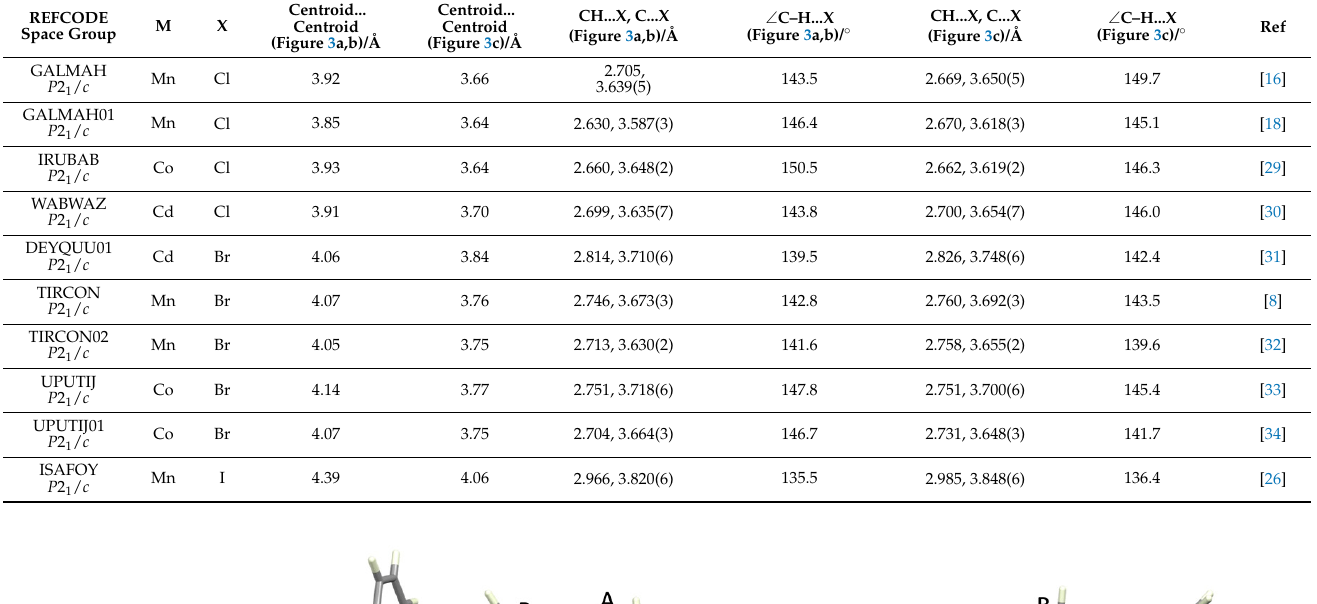
Table 2. Metric parameters for the face-to-face π -stacking and CH...X contacts in the centrosymmetric dimeric motifs in the first group of non-solvated cis- [M(bpy) 2 X 2 ].